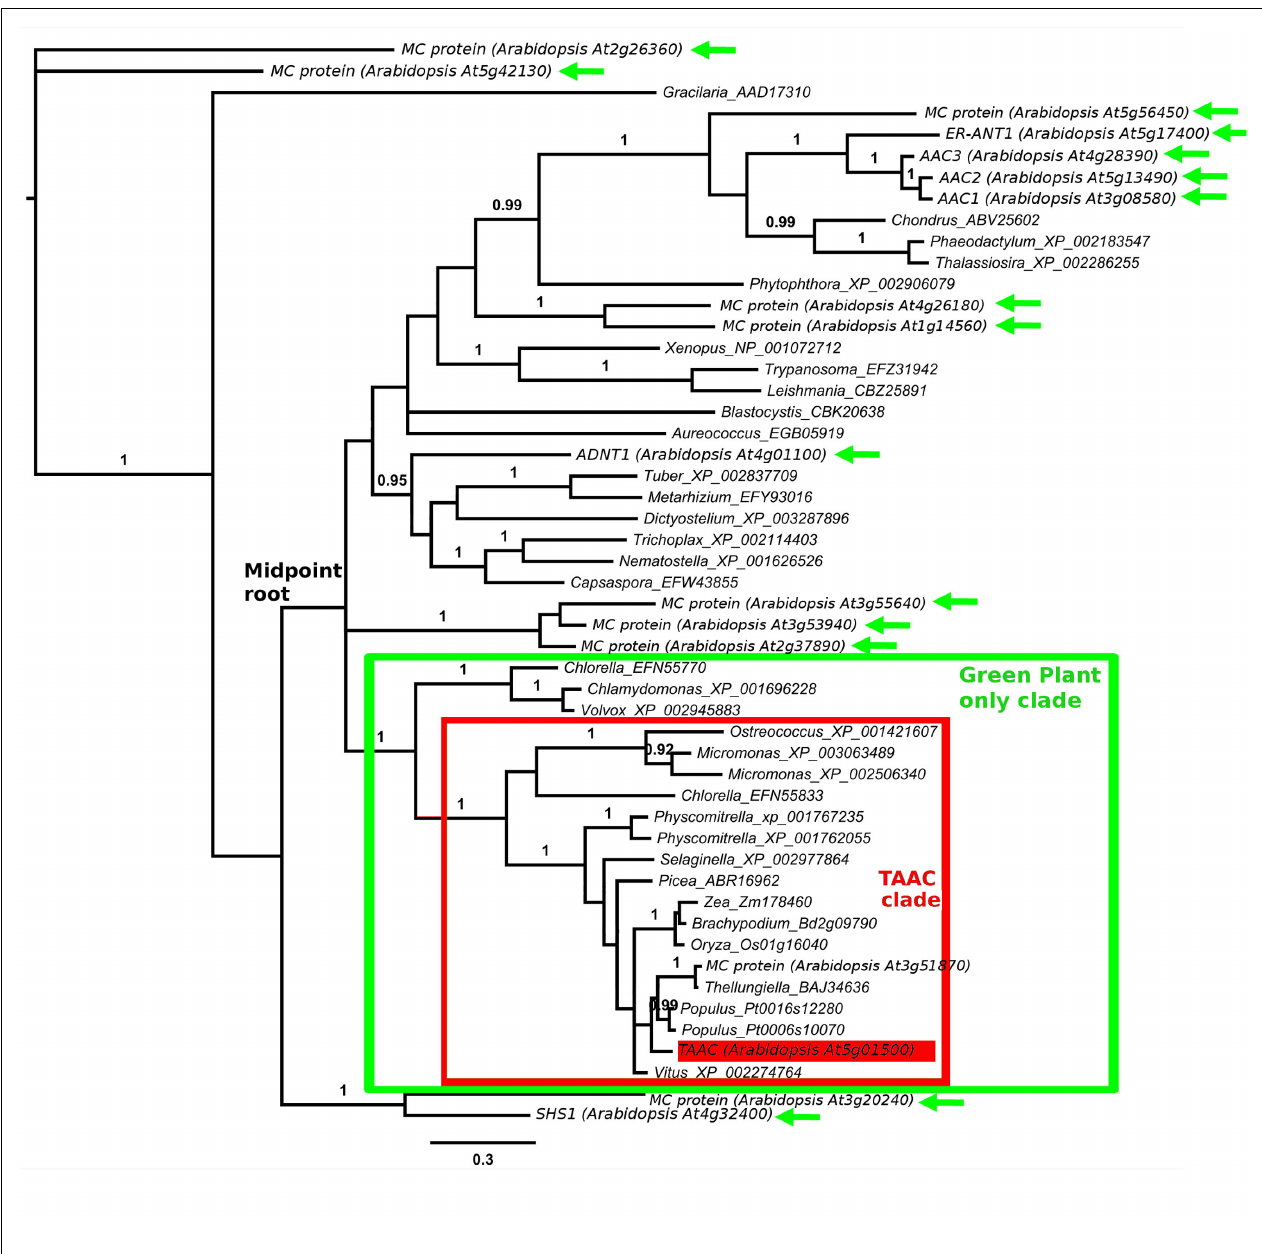
available) and names of genera within which the proteins are found.The position of Arabidopsis TAAC is highlighted in red.The scale bar indicates substitutions per site. Posterior probabilities ≥ 0.90 of clades summarizing two million Markov chain Monte Carlo generations (of a reversible model jump protein Bayesian analysis in MrBayes 3.1.2) are shown above branches.The results discussed are robust to an alternative alignment (MAFFT, not